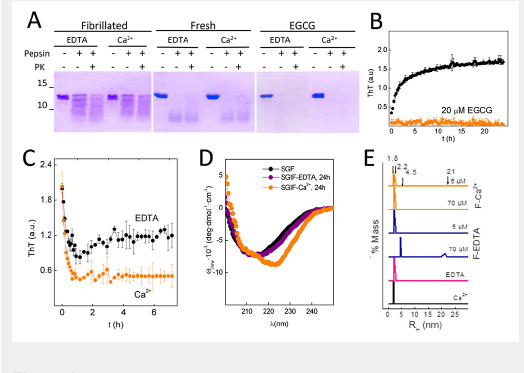
Amyloid fibrils protect rGad m1 from protease digestion and function as depots releasing distinct species. ( A ) sodium dodecyl sulfate polyacrylamide gel electrophoresis (SDS-PAGE) analysis of gastric (pepsin at pH 2.0) and gastrointestinal (pepsin at pH 2.0 followed by proteinase K at pH 7.4) digestions of freshly prepared solutions or after 36 h of fibrillation in SGF, in the absence and presence of 20 μM of epigallocatechin gallate (ECGC), show amyloid-assembly protects monomers from proteolysis. Gels were stained with Coomassie blue. ( B ) Incubation of rGad m 1 with ECGC (20 μM) prevents the increase in thioflavin T (ThT) fluorescence due to fibrillation. Incubation was performed for 15 min in simulated gastric fluid (SGF) and then brought to simulated intestinal fluid (SIF) conditions. Data correspond to two independent experiments performed in triplicate. ( C ) Time-course decrease of ThT fluorescence of rGad m 1 fibrils resuspended in SIF containing either 5 mM EDTA or 5 mM CaCl 2 indicates amyloid disassembly. ( D ) Evolution of the circular dichroism (CD) spectrum of rGad m1 fibrils after resuspension in SIF containing either 5 mM EDTA or 5 mM CaCl 2 reveal effects of amyloid disassembly on secondary structure. Spectra were recorded 3 h after resuspension. ( E ) DLS analysis of soluble rGad m 1 obtained in the supernatant of a 100,000 x g centrifugation of amyloid fibrils resuspended in SGF and SIF containing either 5 mM EDTA or 5 mM CaCl 2 show the release of monomers and oligomers. Species with R H of 1.8 ± 0.1 nm and 2.2 ± 0.2 nm correspond to Ca 2+ -bound and free monomers, and those with 4.5 ± 0.5 nm and 21 ± 0.5 nm to oligomers.